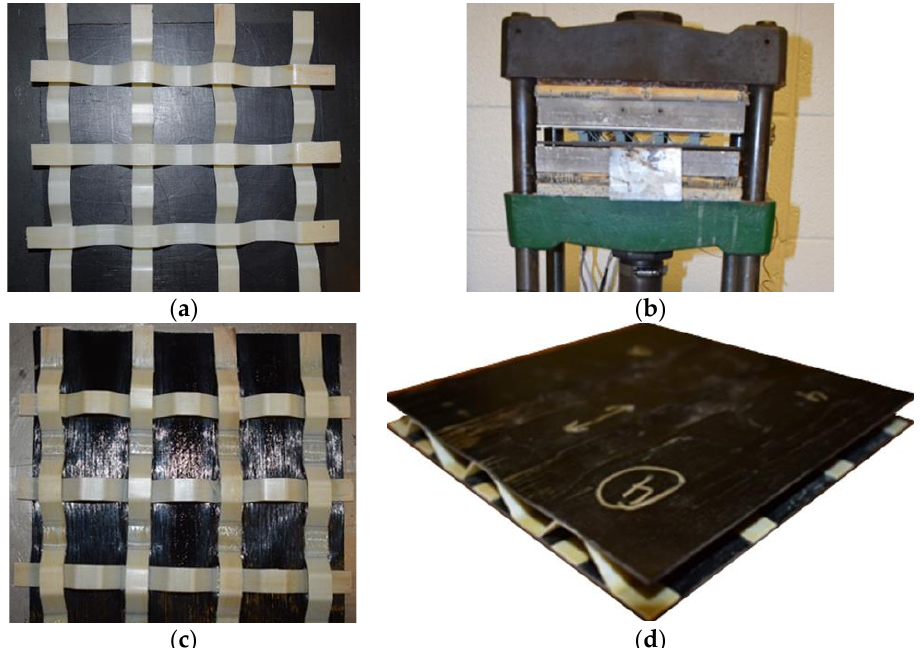
Figure 16. Bonding Sequence for Compression Molded Specimens, ( a ) core positioning, ( b ) press bonding of truss segments to the lower facesheet, ( c ) a view of the joined truss core and facesheet, and ( d ) the completed baseline Navtruss sandwich panel.